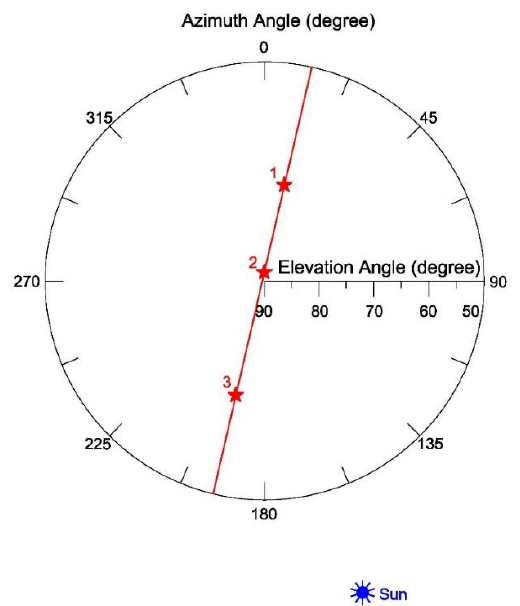
Figure 3 . Sky plot with satellite azimuth and elevation angles at the time of acquisition for the three WV3